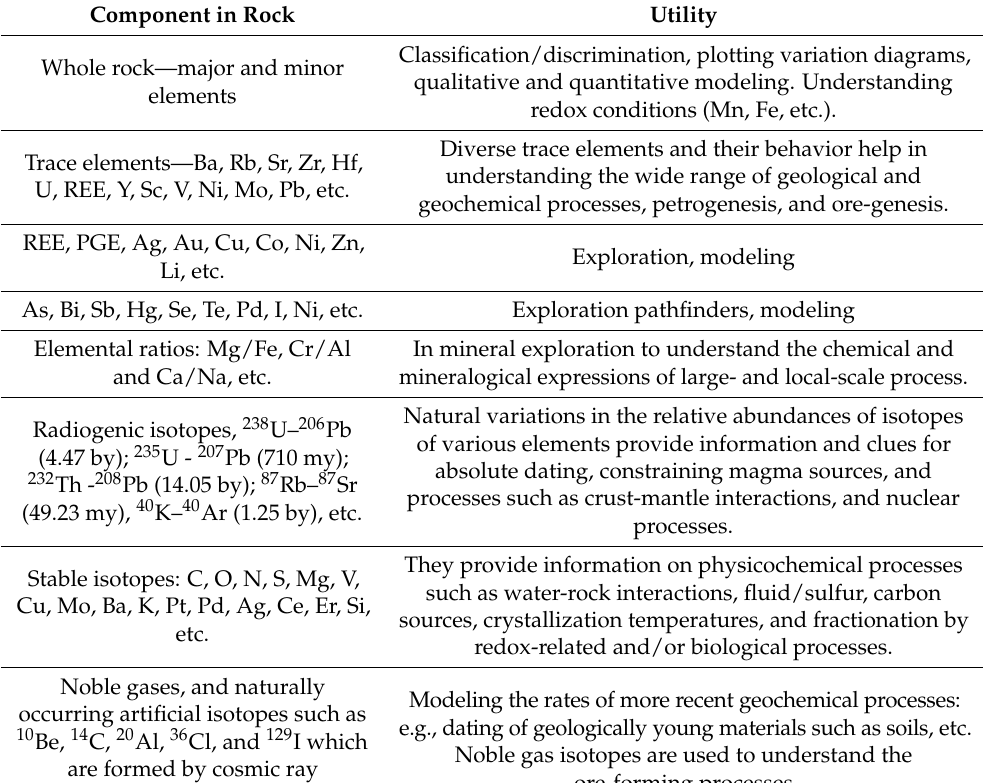
Table 1. Requirements of element/isotope data for understanding various geochemical processes including ore formation.